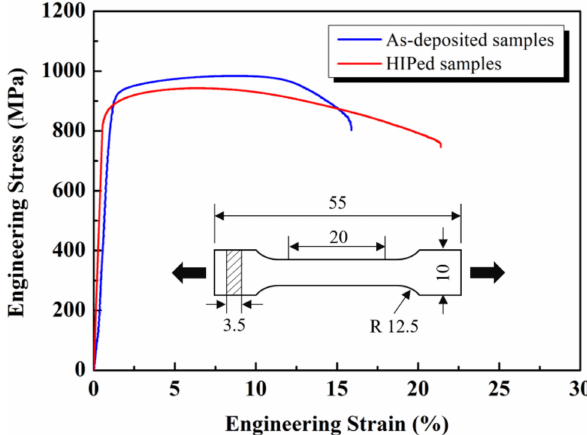
Figure 6. Tensile mechanical properties of as-built and HIPed samples.